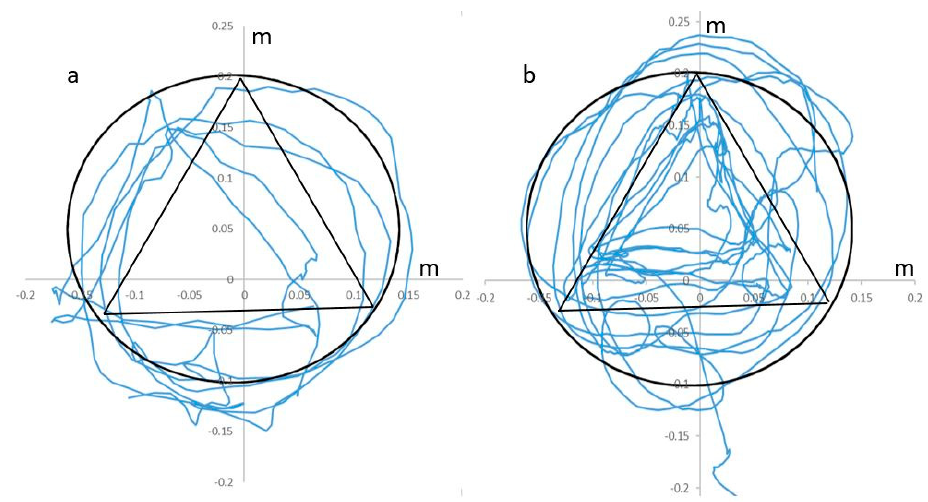
Figure 3. Trajectory of movement during upper extremity AR-Rehabilitation on the 1 and 10-day sessions (patient from A-Rehab-Traditional-AR group as an example); ( a ) 1st session and ( b ) 10th session. Trajectory of movement on X and Y coordinates by the left hand forefinger during execution of the Static domain task: black line—given trajectory, blue line—real trajectory of forefinger. Comparisons of movement parameters between 1st and 10th motor sessions: Variability of movements: P 1–10 < 0.001 *; Number of completed tasks: P 1–10 < 0.001 *; Maximum duration in one approach: < 0.001 *. * Significant; p < 0.05.